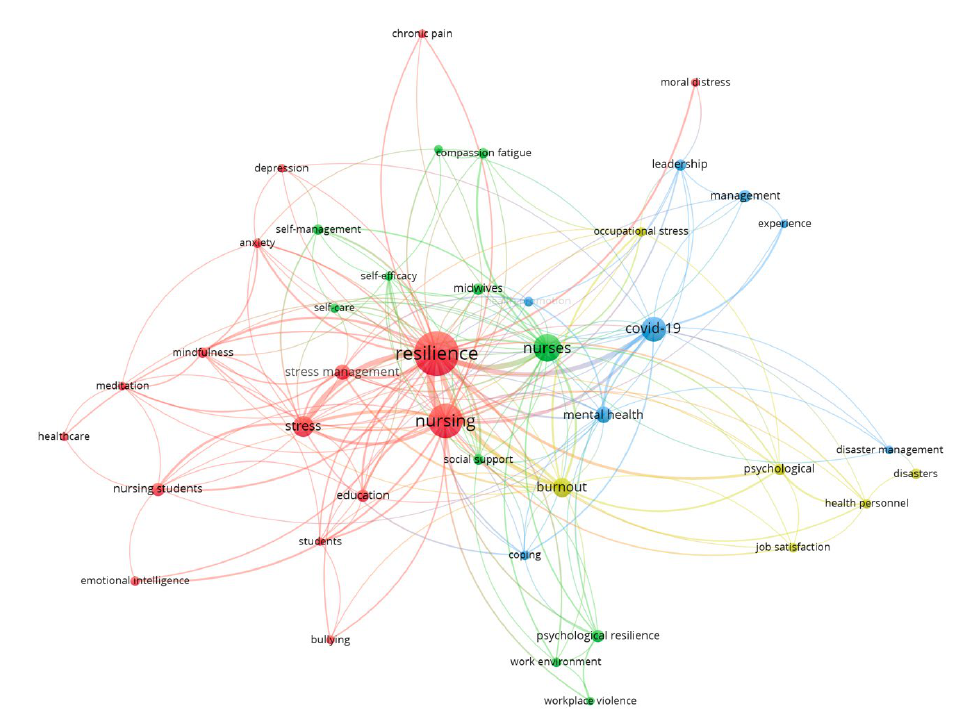
Fig. 2. The network map of keyword co-occurrence, 2000–2022 (up to 7 September). Source : developed by the authors based on Web of Science data